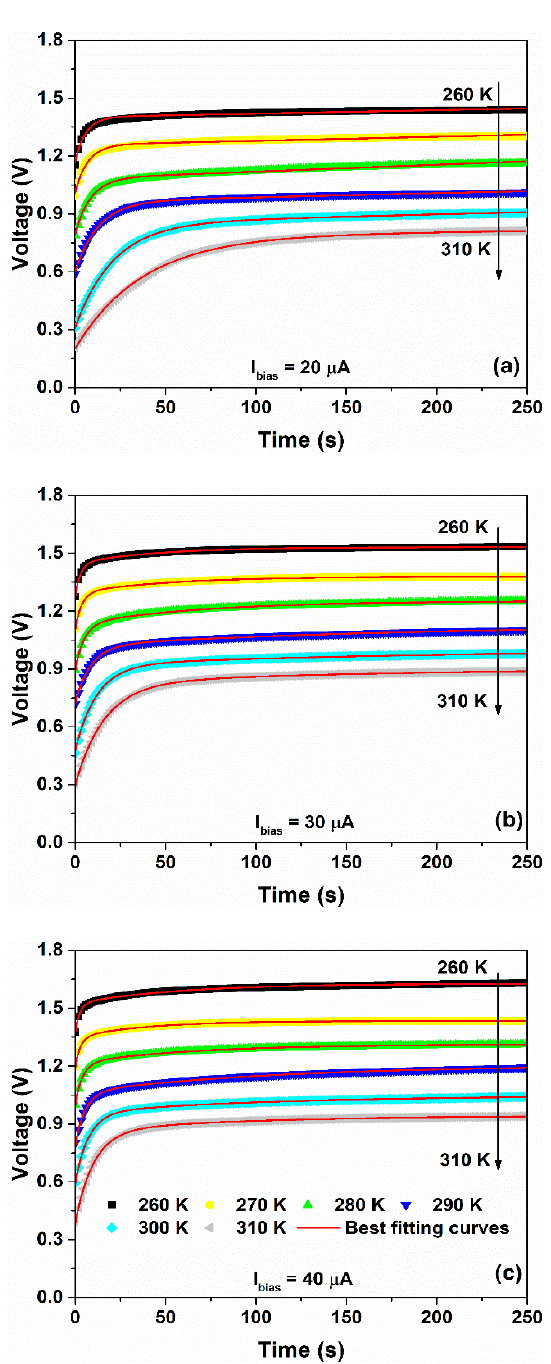
Figure 9. Time evolution of the voltage measured across the device under operating conditions at ( a ) 20 µ A, ( b ) 30 µ A and ( c ) 40 µ A as a function of the temperature between 260 and 310 K, respectively. The best fitting curves, shown as red solid lines, are obtained from Equation (5).